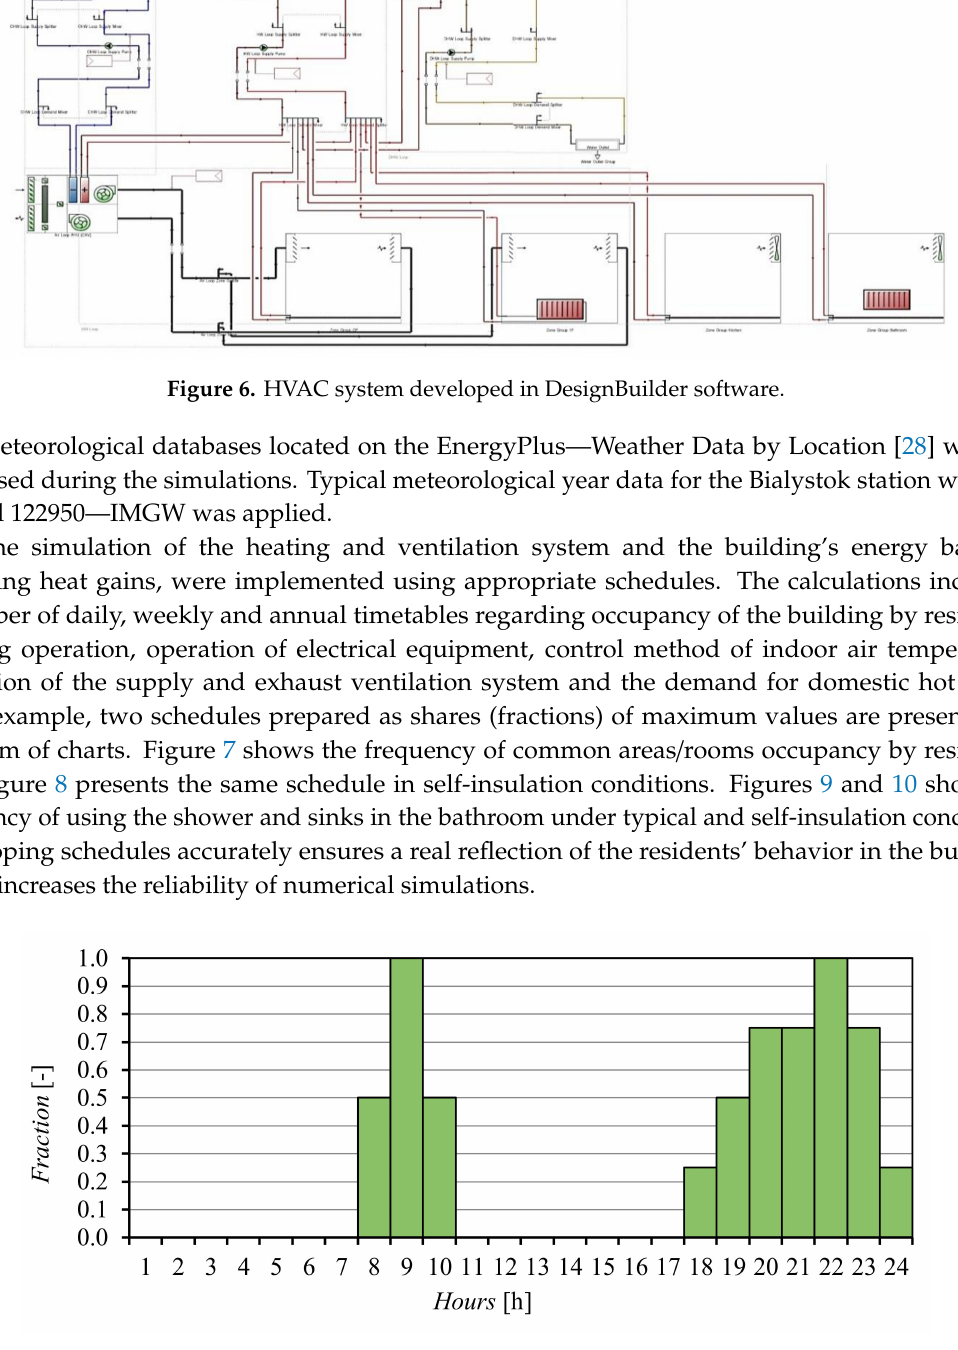
Figure 7. Daily schedule of occupation of common spaces by residents of the